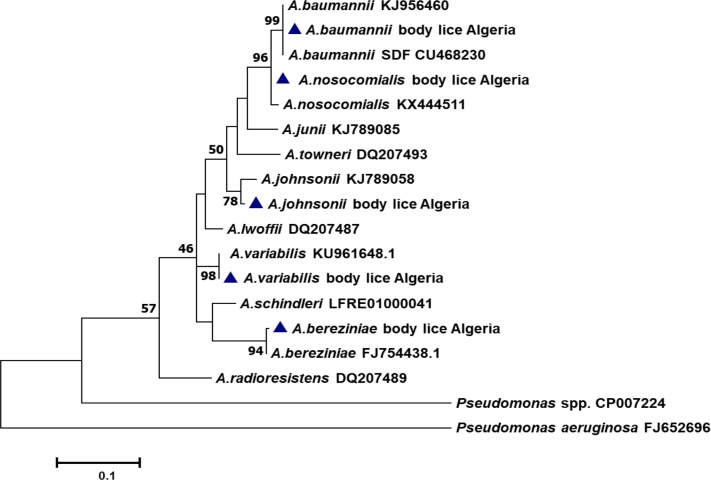
Phylogenetic tree highlighting the position of the Acinetobacter species identified in body lice compared to another Acinetobacter available in the GenBank database.Phylogenetic inferences were conducted in MEGA 7 using the maximum likelihood method based on the Kimura 3-parameter model for nucleotide sequences. GenBank accession numbers are indicated at the end. Statistical support for internal branches of the tree was evaluated by bootstrapping with 1,000 iterations.